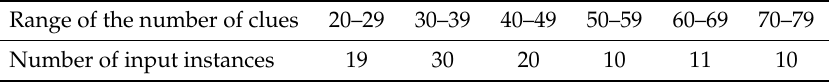
Table 1. Distribution of input instances with respect to the number of